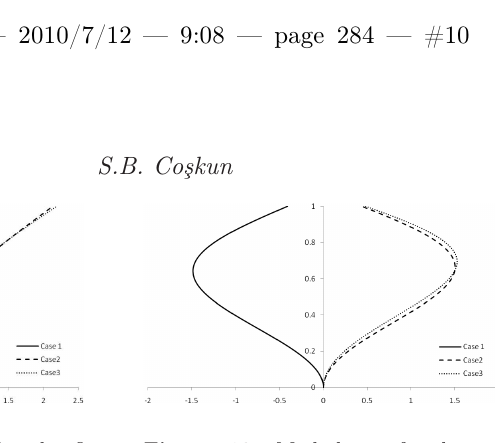
Figure 12. Modeshapes for the second mode – quadratic